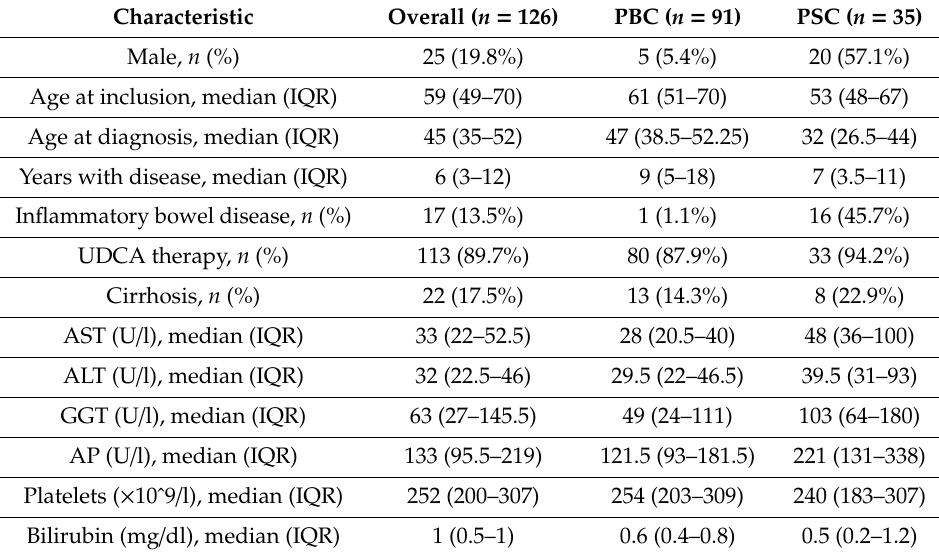
Collective Characteristics: This table gives an overview of the examined cohort and their characteristics. IQR = Interquartile range, UDCA = Ursodeoxycholic acid, AST = Aspartat-Aminotransferase, ALT = Alaninaminotransferase, GGT = Gamma-Glutamyltransferase, AP = Alkaline